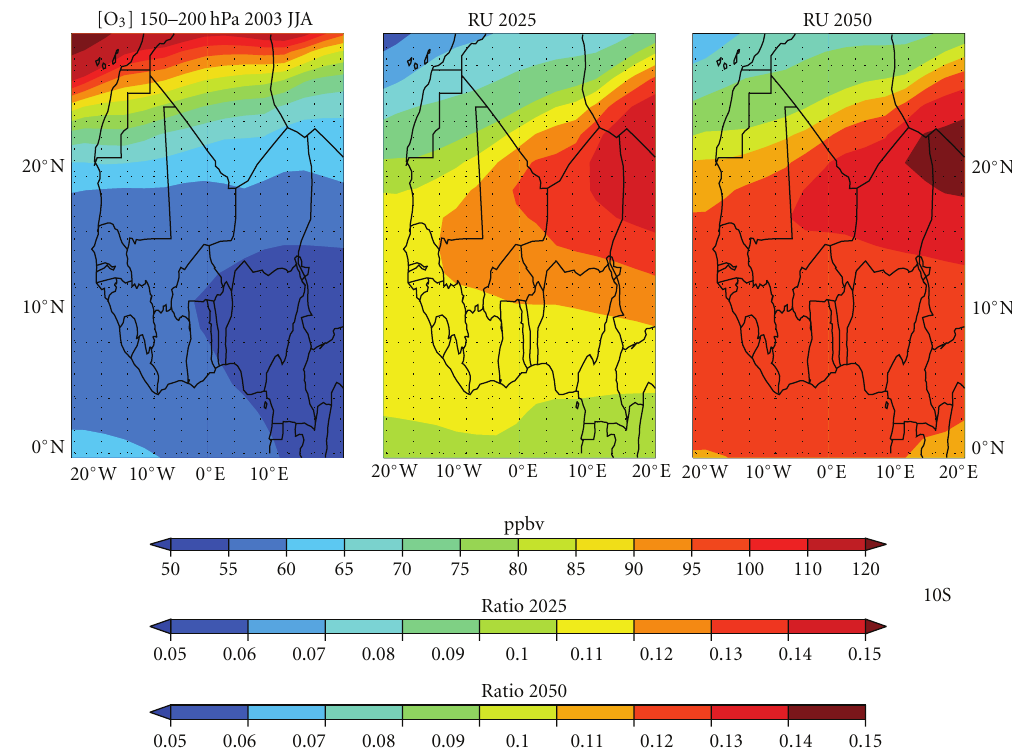
Figure 7: The seasonal distribution of tropospheric O 3 between 150–200 hPa over West Africa. The corresponding RU is shown for both 2025 (middle) and 2050